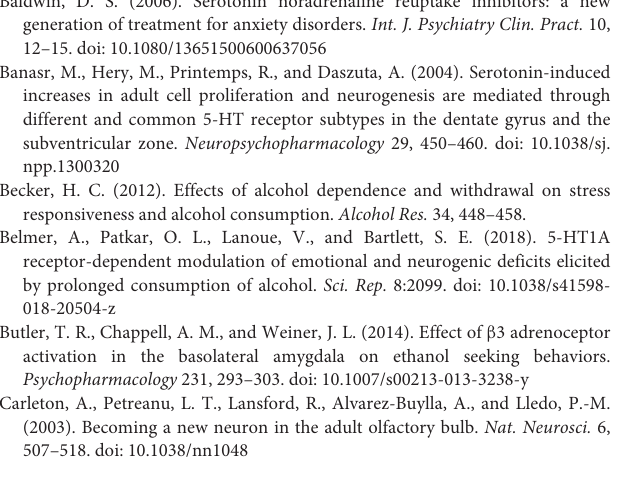
TABLE S1 | Statistical analysis showing normality of cell counts using three different tests. Results of the normality tests are highlighted in yellow. ns, non-significant; EtOH, ethanol; Pind, pindolol; Veh, vehicle. TABLE S2 | Two-way ANOVA analysis of BrdU cells co-labeling ( Figure 3D ): multiple comparison using Bonferroni Post hoc Analysis. Significant results are highlighted in